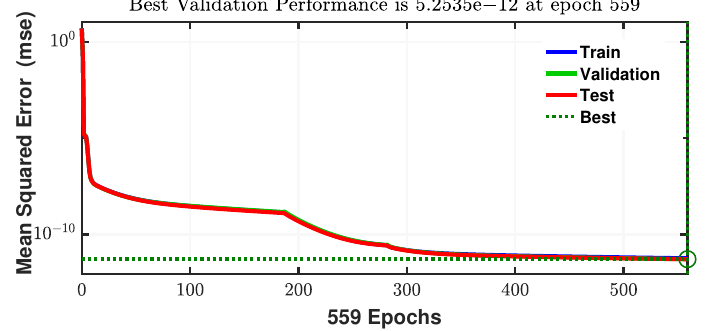
Figure 6. Neural network training performance.